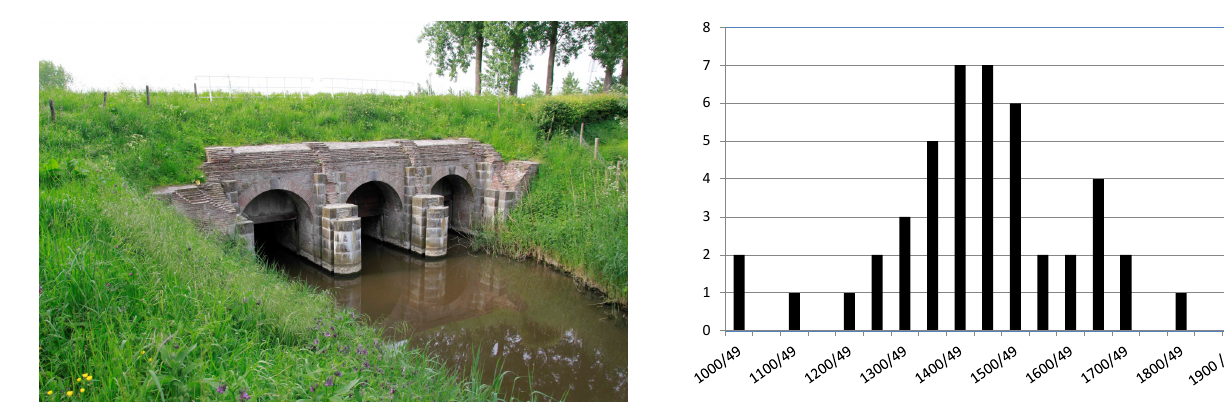
Figure 6. Number of flood events caused by storm surges in the SW Netherlands, 1000–2000, per half a century. This number does not say anything about intensity, damage or scale; most of the events barely flooded 5% of the territory, others (16 November 1530, 12 November 1570) perhaps about one third.